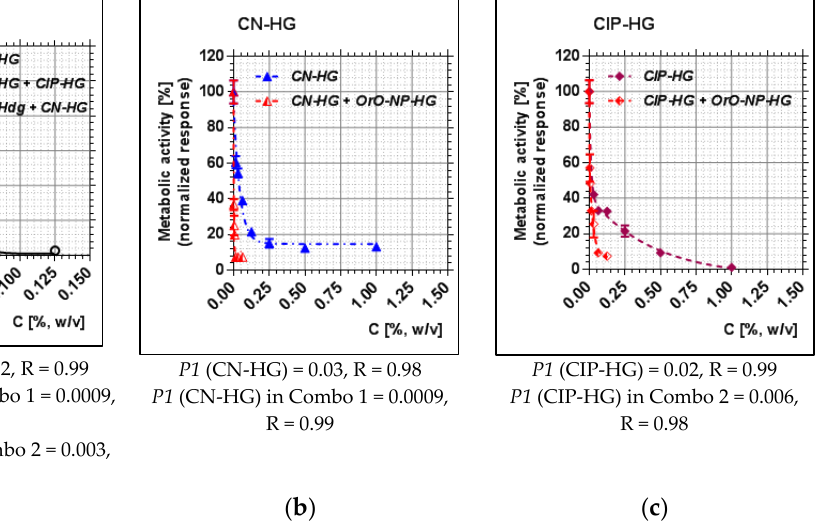
Figure 4. Metabolic activity of MRSA after treatment with OrO-NP, gentamicin and ciprofloxacin and synergistic combinations in hydrogels: ( a ) OrO-NP-HG, single application and in combinations with CN-HG or CIP-HG; ( b ) CN-HG, single application and in combination with OrO-NP-HG; ( c ) CIP-HG, single application and in combination with OrO-NP-HG. Legend: ( a ) OrO-NP-HG; ( b ) CN-HG; ( c ) CIP-HG; P1 —inhibitory constant, which may be interpreted as the dose achieving 50% inhibition; R—correlation coefficient; OrO—oregano oil; NP—nanoparticles; HG—hydrogel; CN—gentamicin;